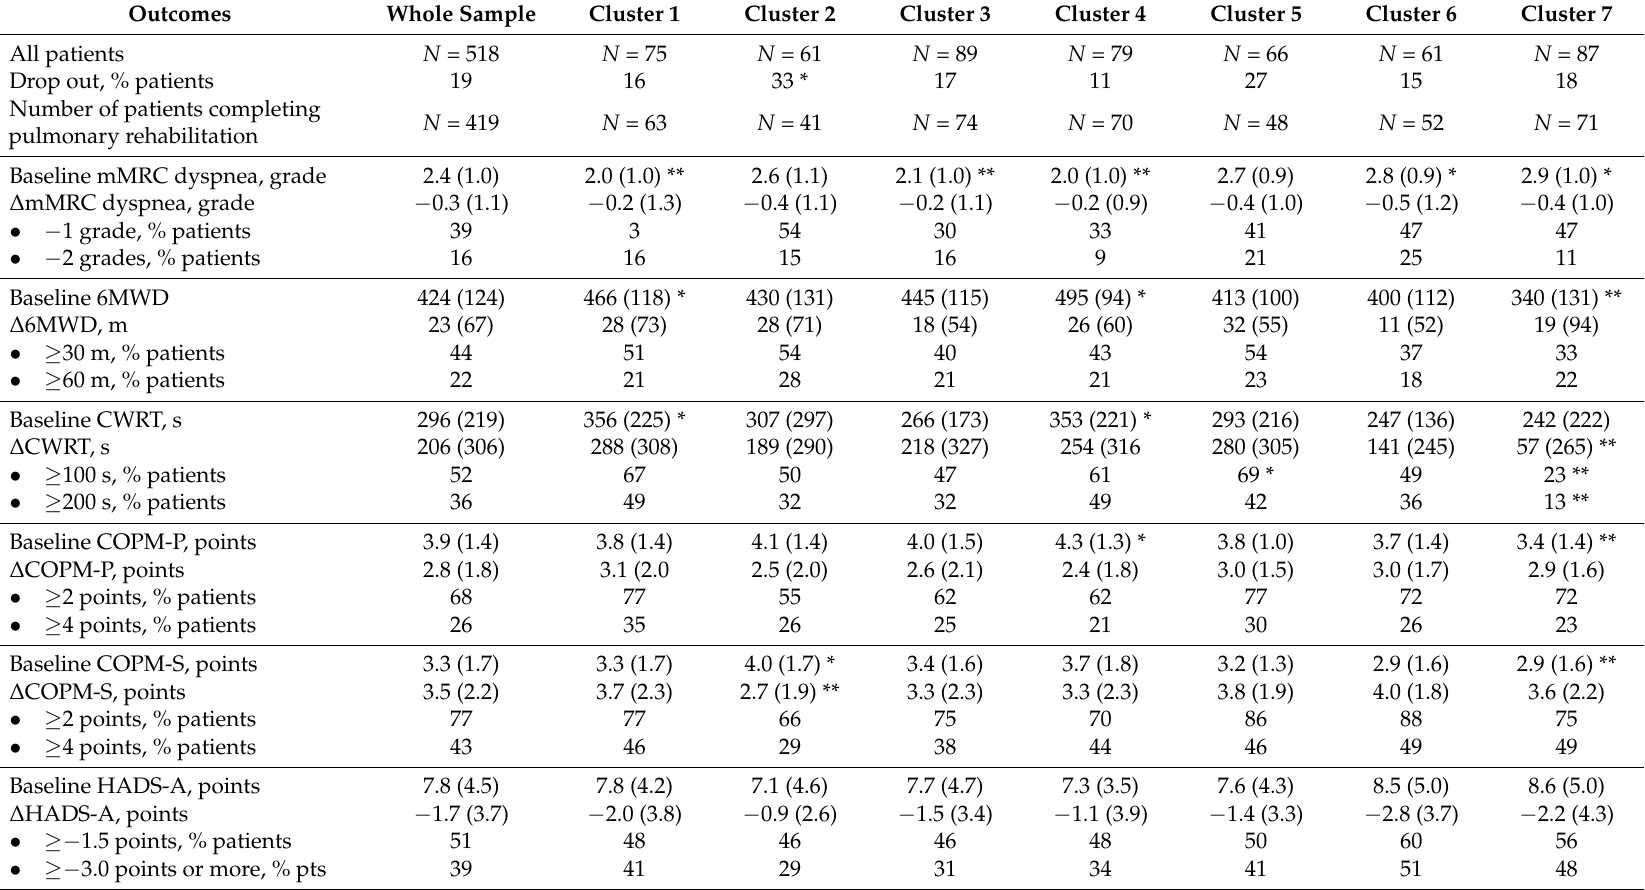
Table 1. Changes following a pulmonary rehabilitation program for the seven lung function